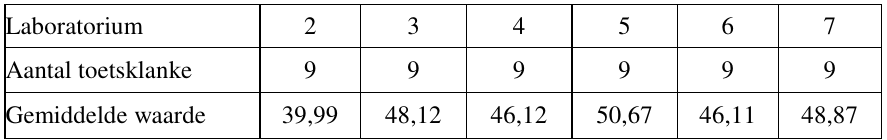
GEMIDDELDE GELYKE LUIDHEIDSWAARDES VAN TOETSKLANKE OP DIE 55